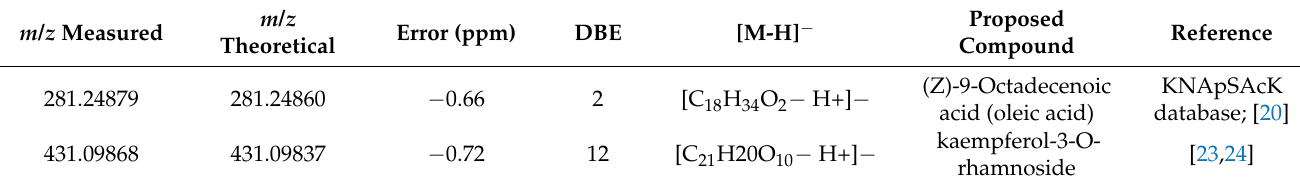
Table 6. Proposed structures for components of the 7C24 fraction of A. crassiflora